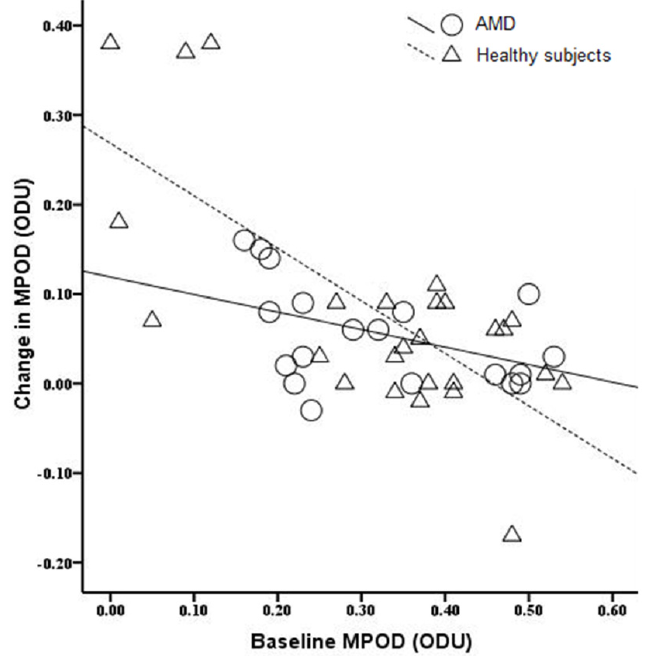
Figure 2. Scatterplot showing the relationship between baseline MPOD levels and the change in MPOD from baseline. MPOD, macular pigment optical density; ODU, optical density